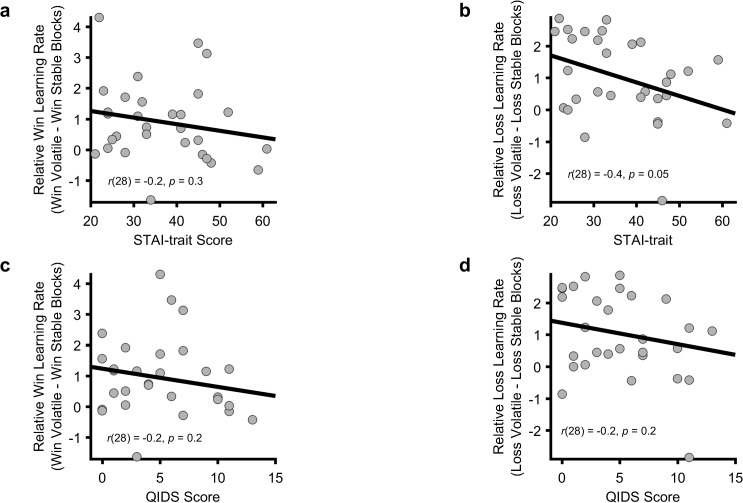
Relationship between symptom scores and behavioural adaptation to volatility.Although participants in the current study were not selected on the basis of their symptoms of depression or anxiety, baseline questionnaires were completed allowing assessment of the relationship between symptoms and task performance. A correlation was found between trait-STAI and the change in learning rate to losses, with participants with higher scores adjusting their learning rate less than those with a lower score (Panel b; r = −0.36, p=0.048). This is the same effect reported by Browning et al., 2015. We did not observe any relationship between either questionnaire measure and change in the win learning rate or between QIDS score and change in loss learning rate (Panels a, c, d; all p>0.19).